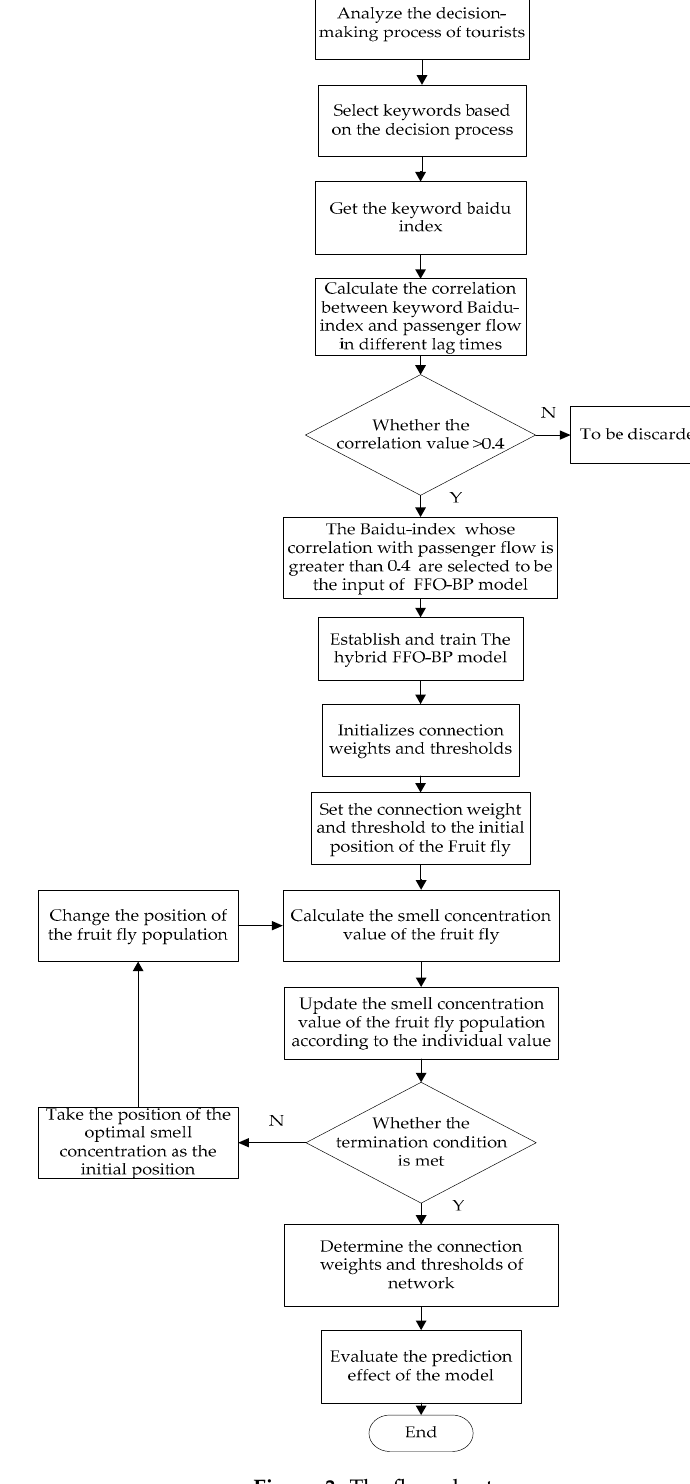
Figure 3. The flow chart.